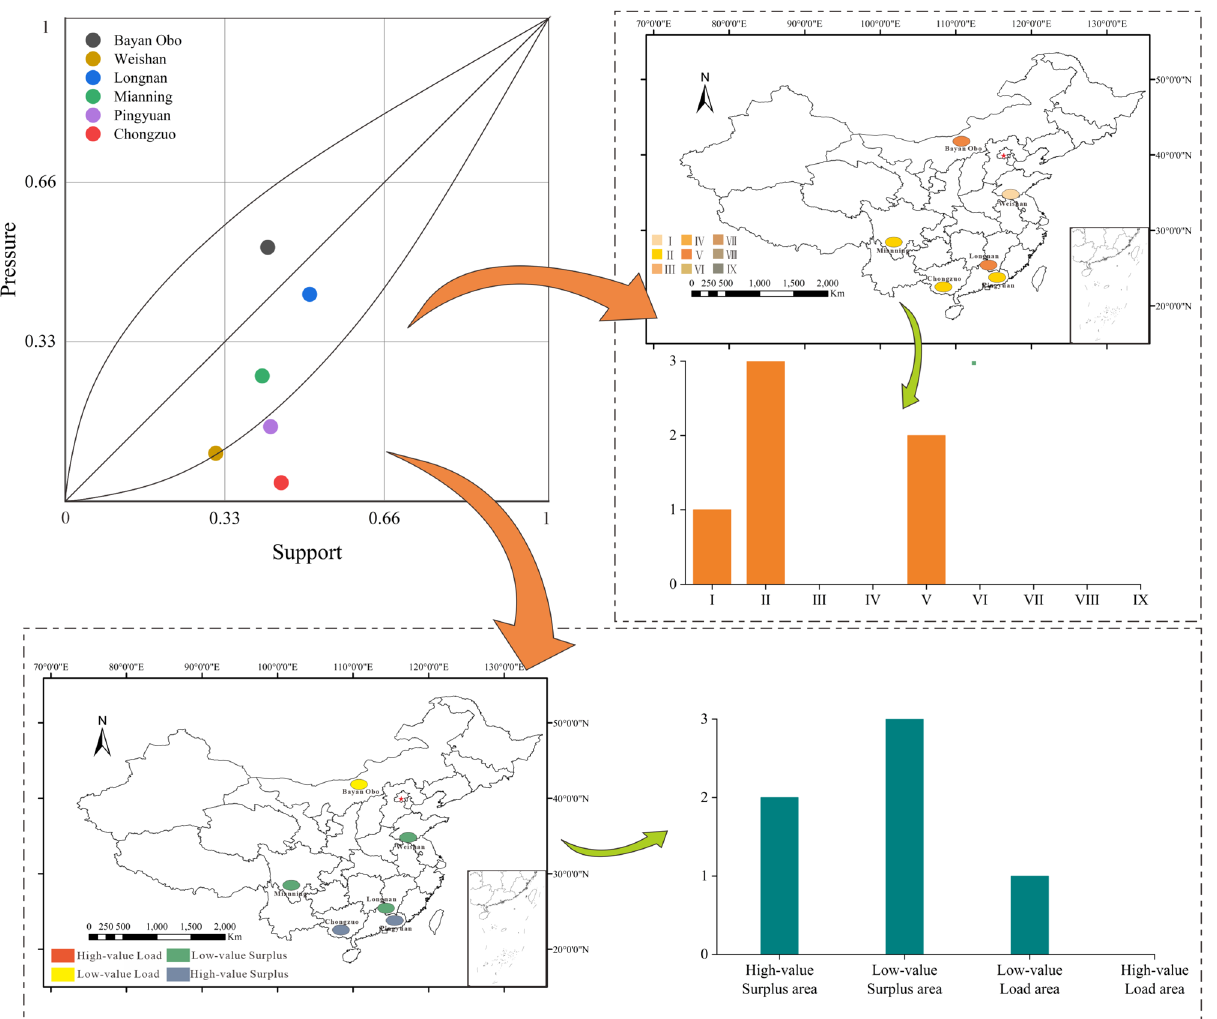
Figure 4. Schematic diagram of the classification of RECC in mining